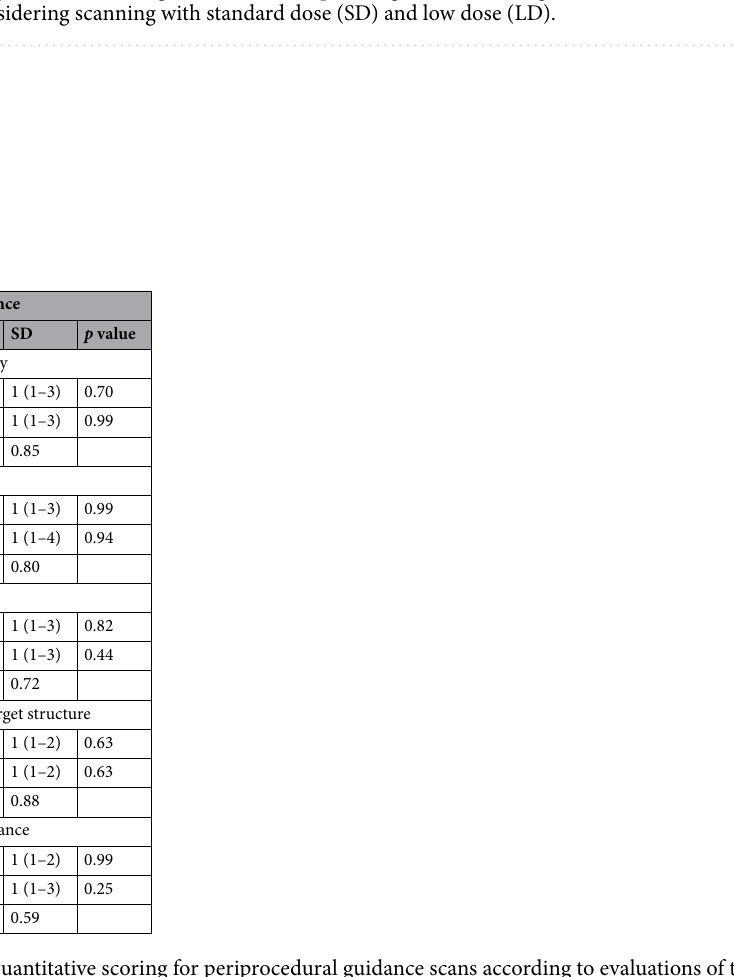
Table 5. Semi-quantitative scoring for periprocedural guidance scans according to evaluations of two readers (R1 and R2) considering scanning with standard dose (SD) and low dose